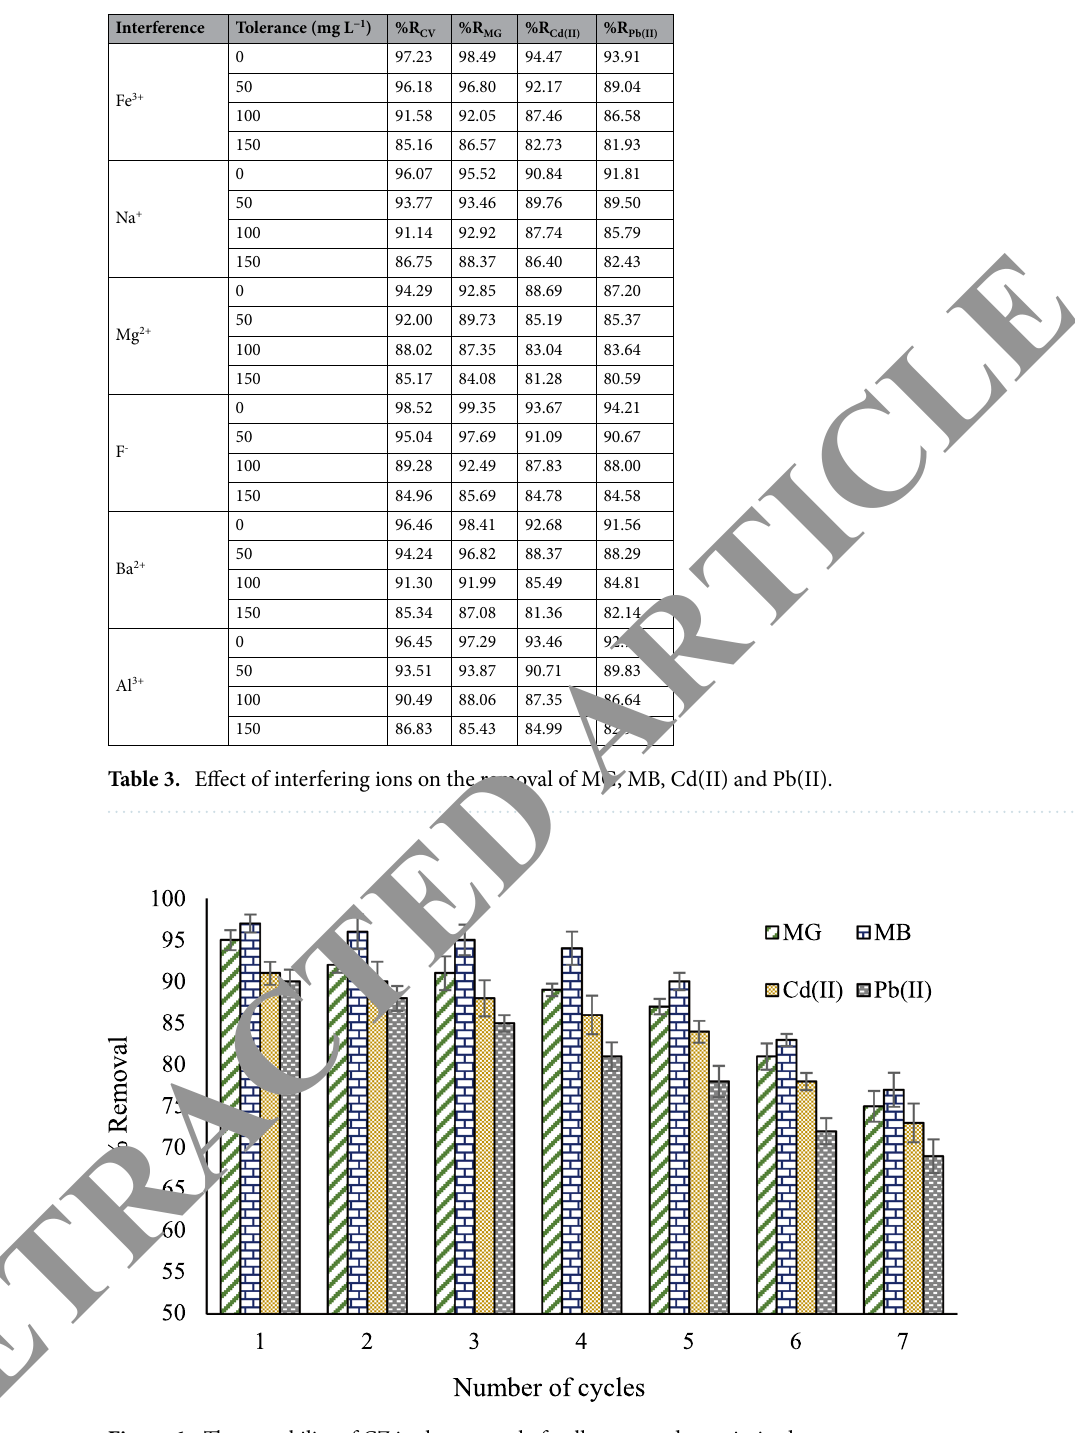
Figure 6. The reusability of CZ in the removal of pollutants under optimized parameters.